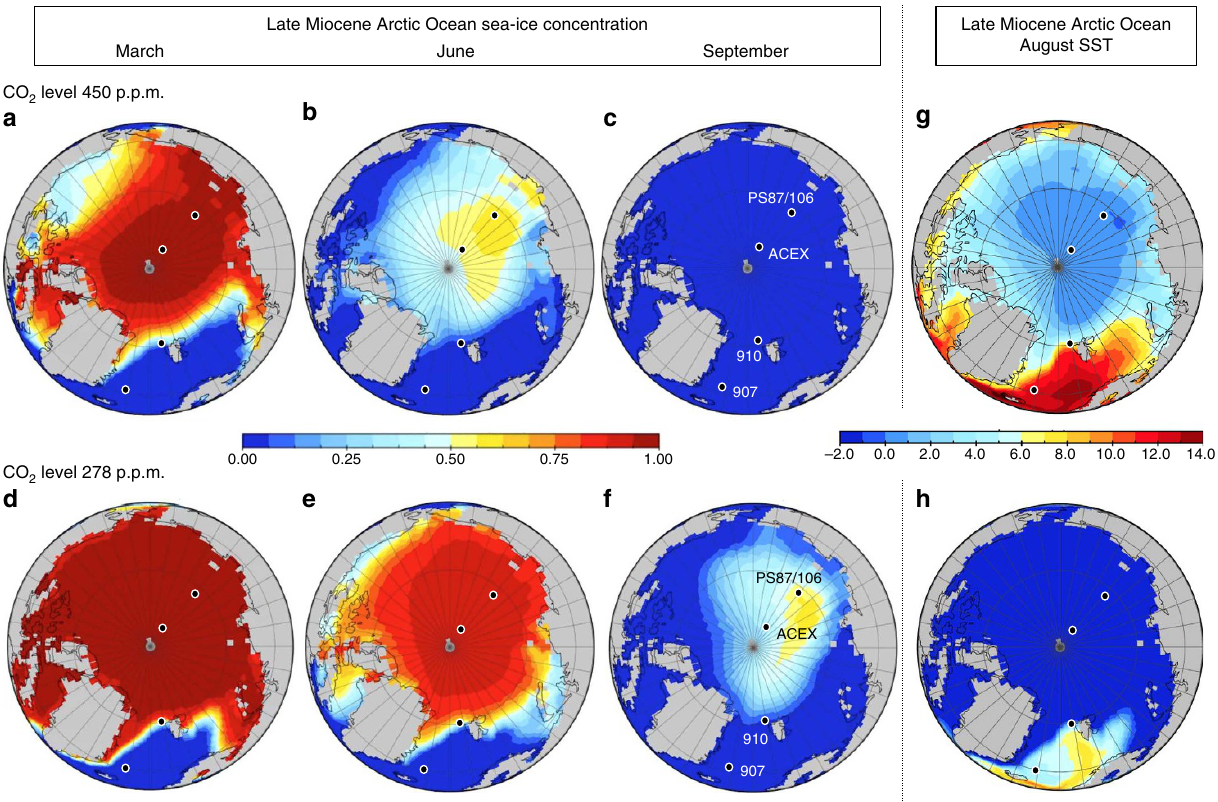
Figure 6 | Late Miocene Arctic Ocean climate simulations for high and low pCO 2 levels using a coupled atmosphere–ocean general circulation model. ( a – c , d – f ) Sea-ice concentrations for March, June and September at 450 and 278p.p.m. CO 2 levels, respectively 32 . ( g , h ) Late Miocene August SST at 450 and 278p.p.m. CO 2 levels, (Fig. 4). The combination of IP 25 and SST data indicates that the